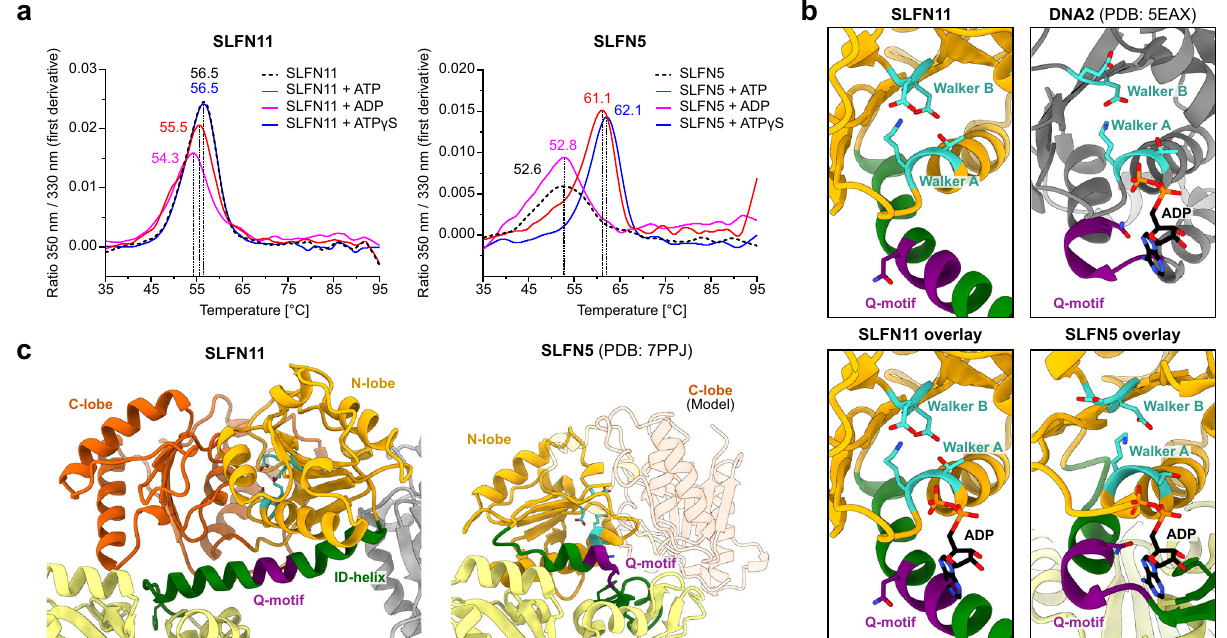
Fig. 4 | Characterization of the SLFN11 helicase domain. a NanoDSF measure- ments of SLFN11 and SLFN5 in presence of different nucleotides or without nucleotide. b Structuralcomparison of helicase domains of SLFN11, SLFN5 (PDB code 7PPJ) and DNA2 in ADP bound state (PDB code 5EAX). Walker motifs and